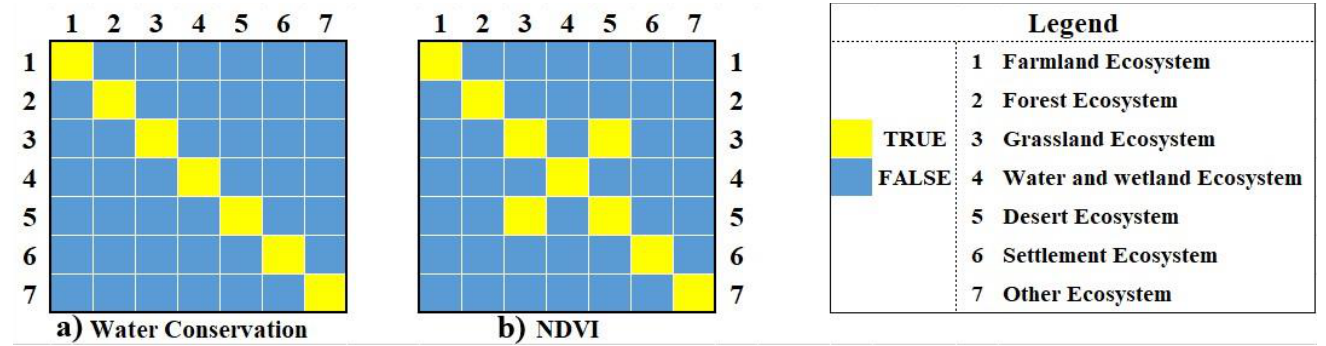
Figure 5. The average value of water conservation and the normalized difference vegetation in- dex (NDVI) in each stratum of the ecosystem types by risk detector. Notes: Ecosystem types 1–7 correspond to farmland, forest, grassland, water and wetland, desert, settlement, and other ecosystems, respectively.